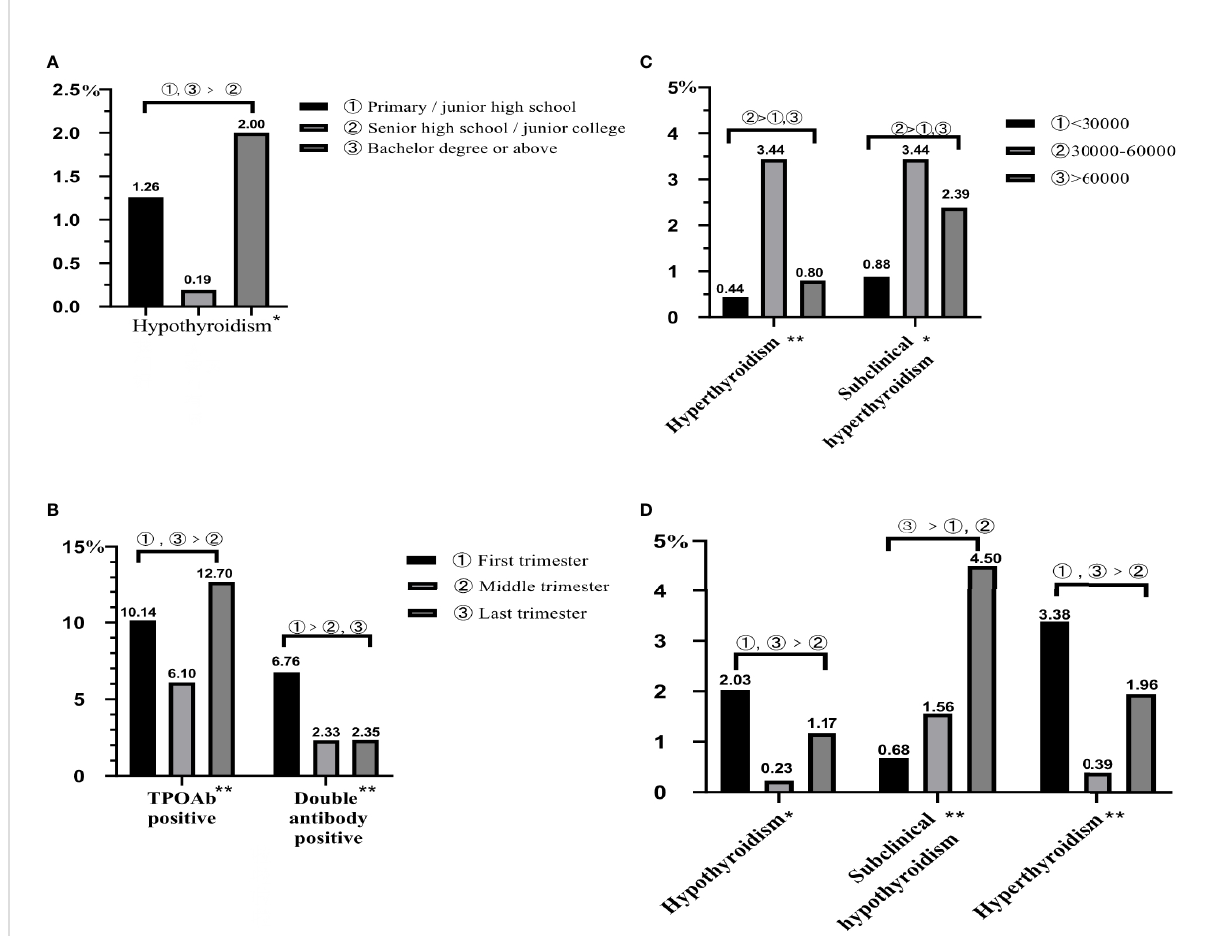
FIGURE 5 The in fl uencing factors of thyroid diseases in pregnant women. All data were presented as rate. (A) The in fl uence of degree of education on hypothyroidism. (B) The in fl uence of gestation on TPOAb positive and double antibody positive. (C) The in fl uence of family annual income on hyperthyroidism and subclinical hyperthyroidism. (D) The in fl uence of gestation on hypothyroidism, subclinical hypothyroidism, and hyperthyroidism. *represents P < 0.05; **represents P <